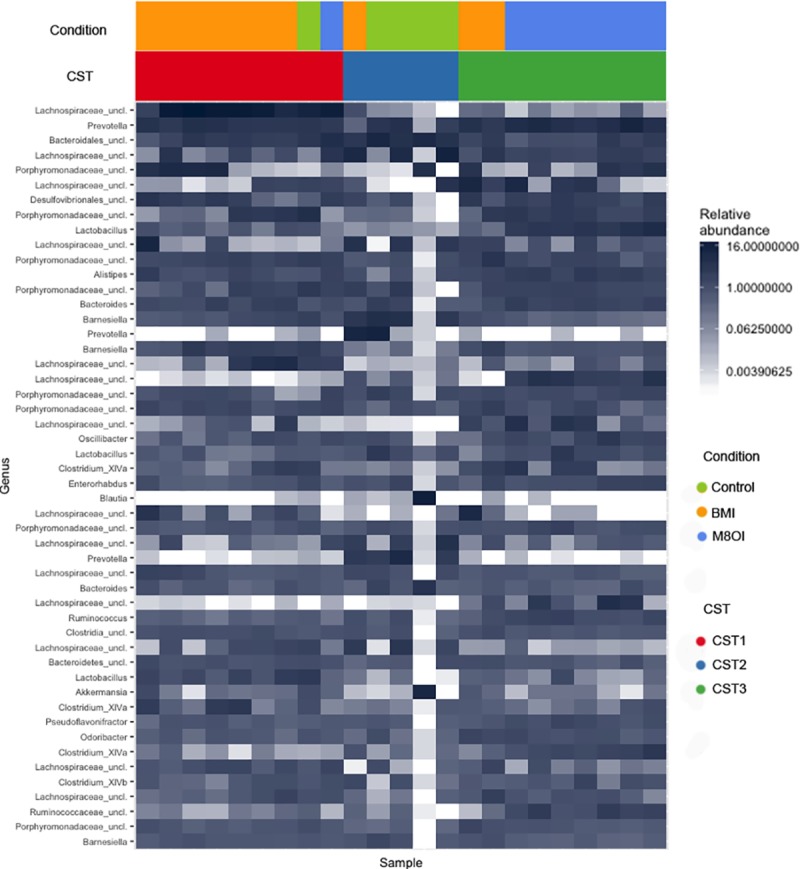
Complete linkage hierarchical clustering identifies three distinct community state types based on relative abundance of bacterial OTUs.Membership of CSTs shows significant association with ionic liquid exposure group and is also linked with sample alpha diversity. Heatmap shows relative abundance of the top 50 most abundant bacterial OTUs. Each tile represents the abundance of a specific OTU (in rows), in the given sample (in columns).